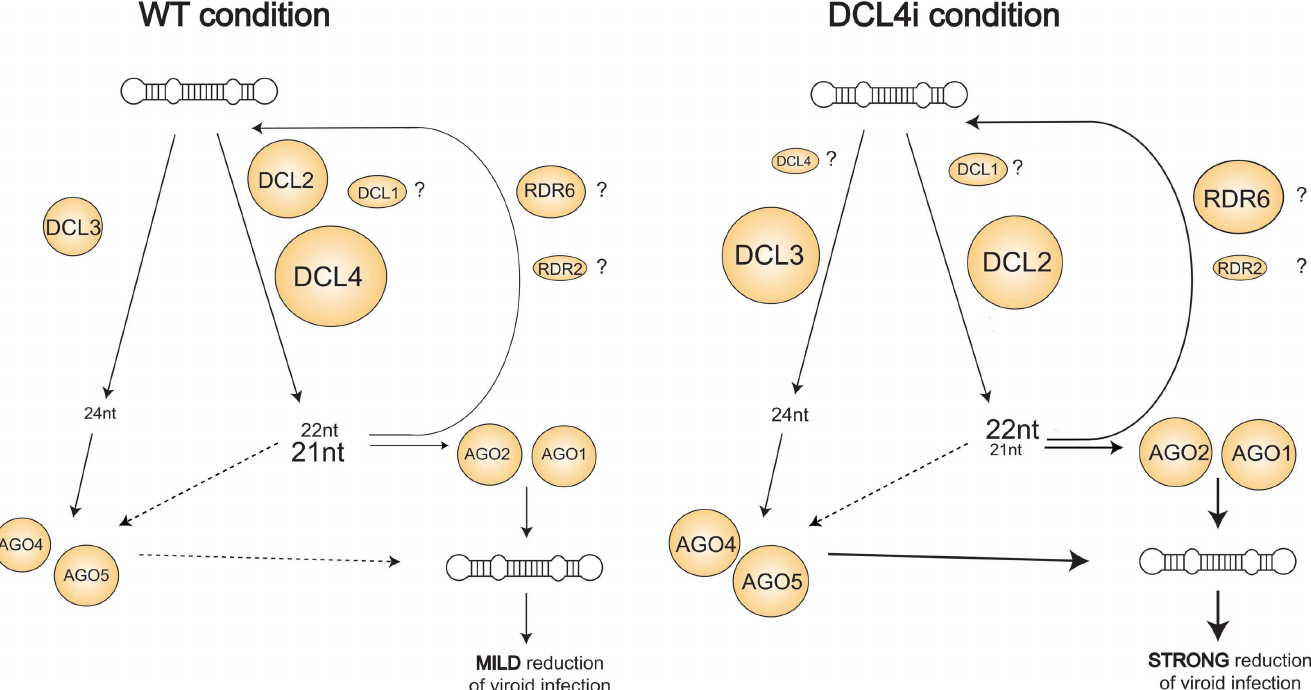
Fig 8. Proposed model of DCL involvement in PSTVd defense. In WT, PSTVd is targeted by at least three DCL enzymes. It is not clear whether DCL1 also contributes to this targeting. 21 and 22nt vd-siRNAs are loadedinto AGO1 and AGO2 whereas 24nt into AGO4 and AGO5. These vd-siRNAs are probablyredirected to target the PSTVd genome. In DCL4i condition, DCL4 is strongly suppressed, thus PSTVd genome is processedpreferentially by a combination of DCL2-DCL3. The contributionof DCL1 in this action remains open. The majority of vd-siRNA producedat this conditionare of 22nt class followedby 24nt class. These are probably uptaken by AGO1, AGO2, AGO4 and AGO5 and are targeting the PSTVd genome in a highly efficiently manner, resulting in a strong reduction of PSTVd